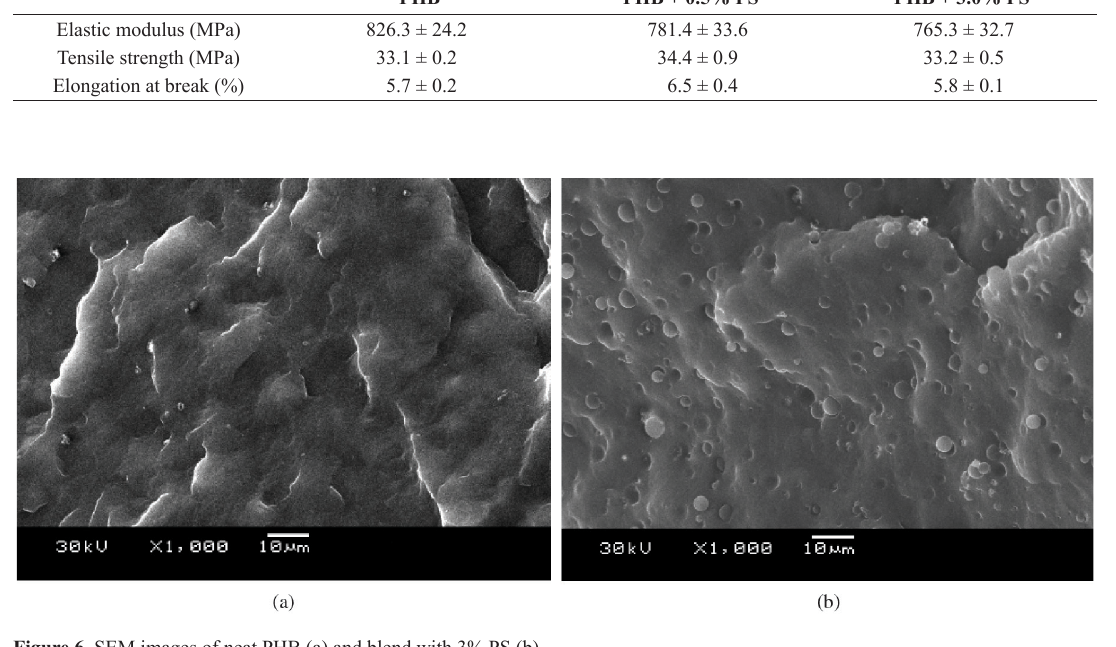
Figure 6. SEM images of neat PHB (a) and blend with 3% PS